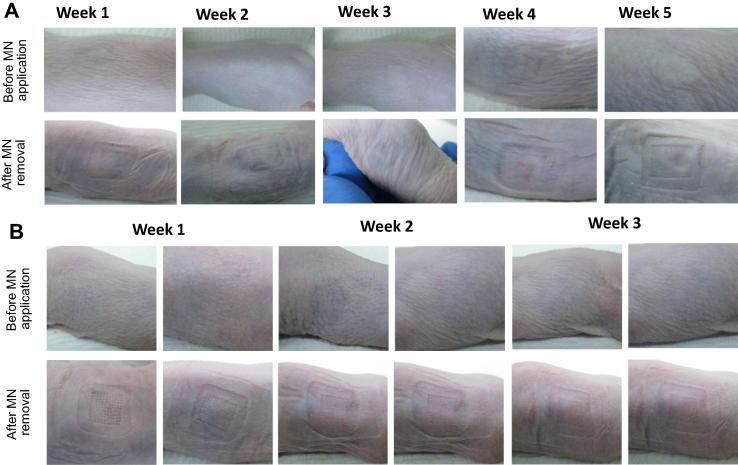
Photographs were taken to monitor skin appearance over the entire duration of the experimental period. Exemplar images are presented here. Images of “no ear punch” male to which 19 × 19 dissolving PMVE/MA MN arrays (A) and “no ear punch” female to which 11 × 11 hydrogel-forming MN arrays (B) were applied.